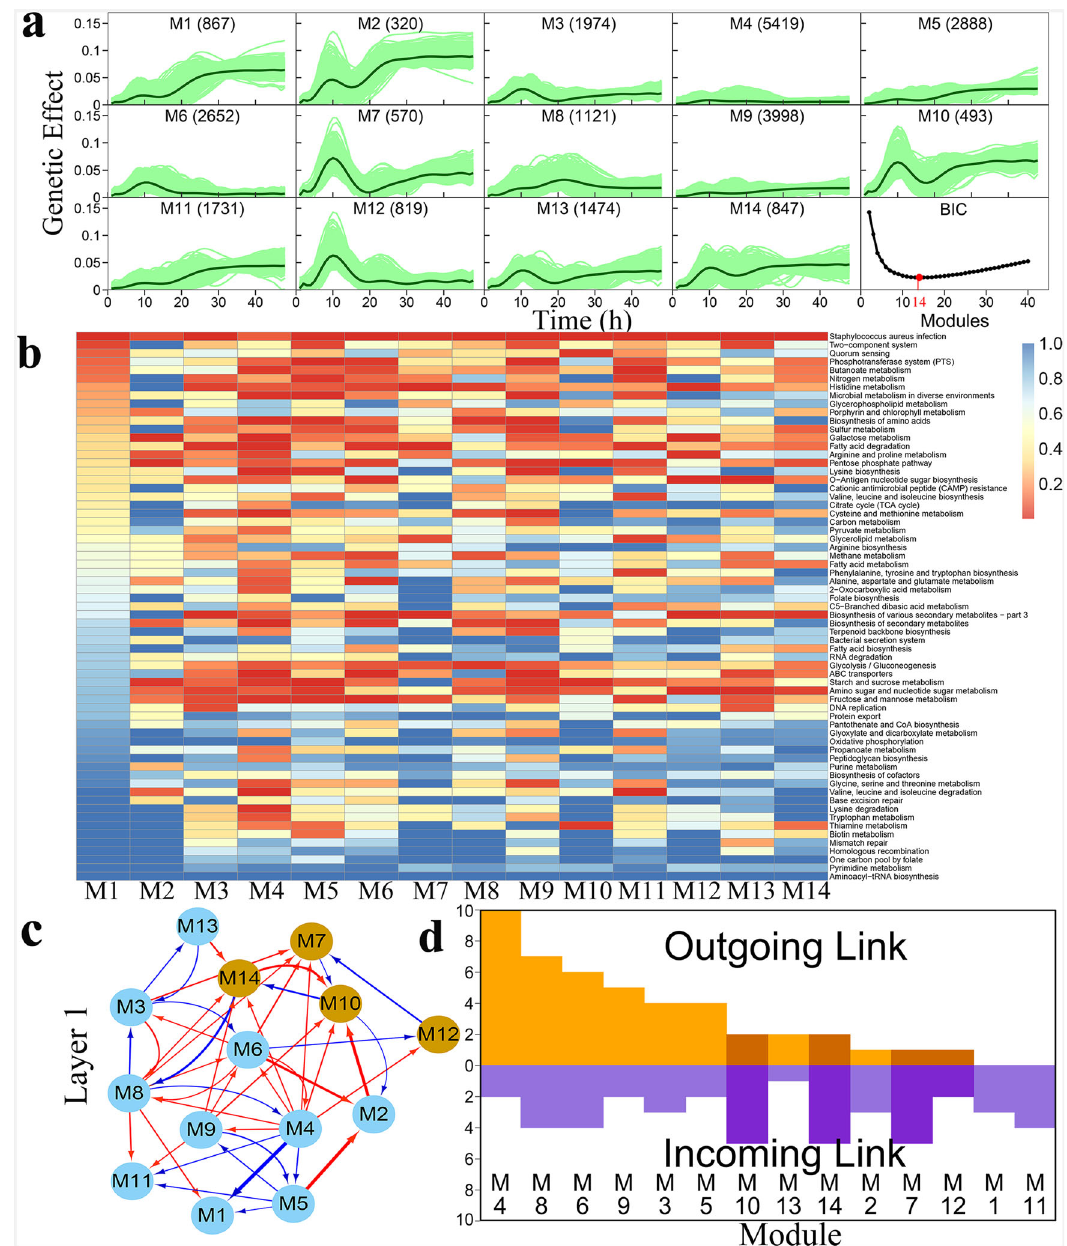
Fig. 3 Identi fi cation of network communities from a large-scale network. a The curves of genetic effects on the phenotypic plasticity of microbial growth trajectory for 14 distinct modules classi fi ed from 25,173 SNPs according to BIC. Thick green line represents the mean curve of all SNPs within modules, with individual SNP-speci fi c curves denoted by thin green lines. b Heatmap of gene functions from 14 modules by gene set enrichment analysis. c The 14-node inter-module network displayed at the fi rst layer of the whole network. QTLs detected by coFunMap are sorted into modules M7, M10, M12, and M14, highlighted in orange. Red and blue arrowed lines stand for the direction of up-regulation and down-regulation, respectively, with the thickness of lines proportional to the strength of regulation. d Distribution of the number of outgoing and incoming links over different modules. The positions of QTL- containing modules are